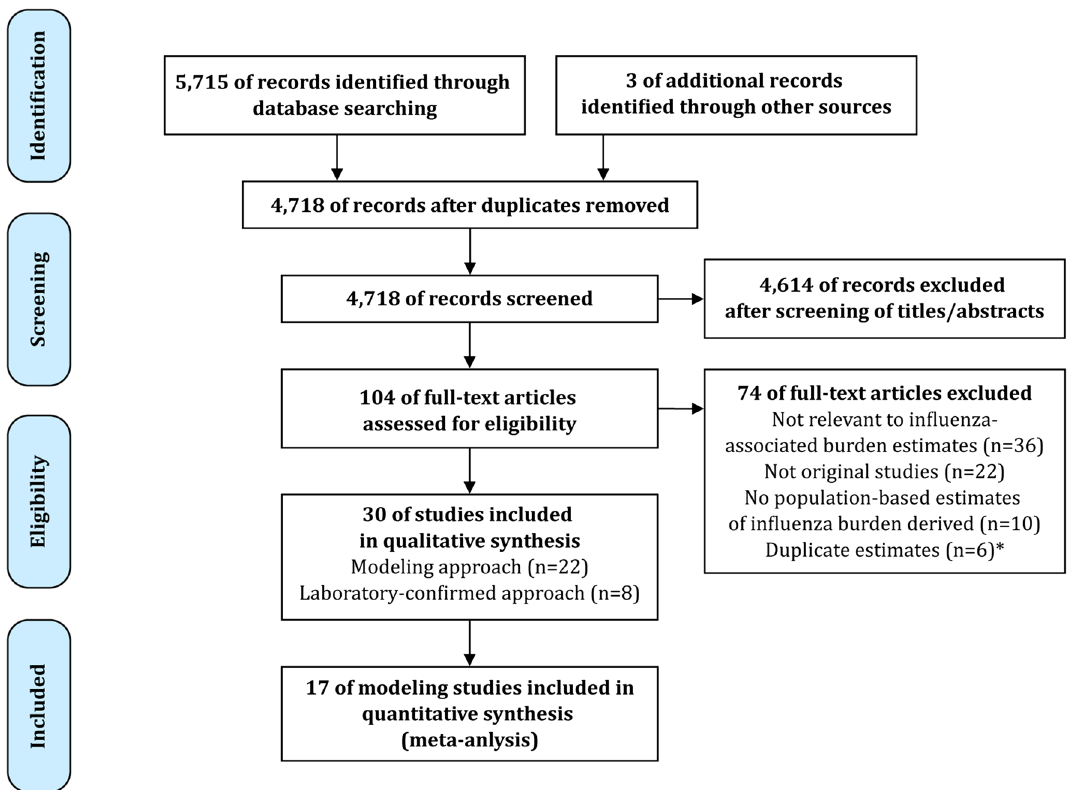
Figure 1. Flow diagram for systematic review process. *If several publications reported on the same study, we only included the publication that provided the most data. The flow diagram was drawn using Adobe Illustrator software, version 22.0.0 (https ://www.adobe .com/produ cts/illus trato